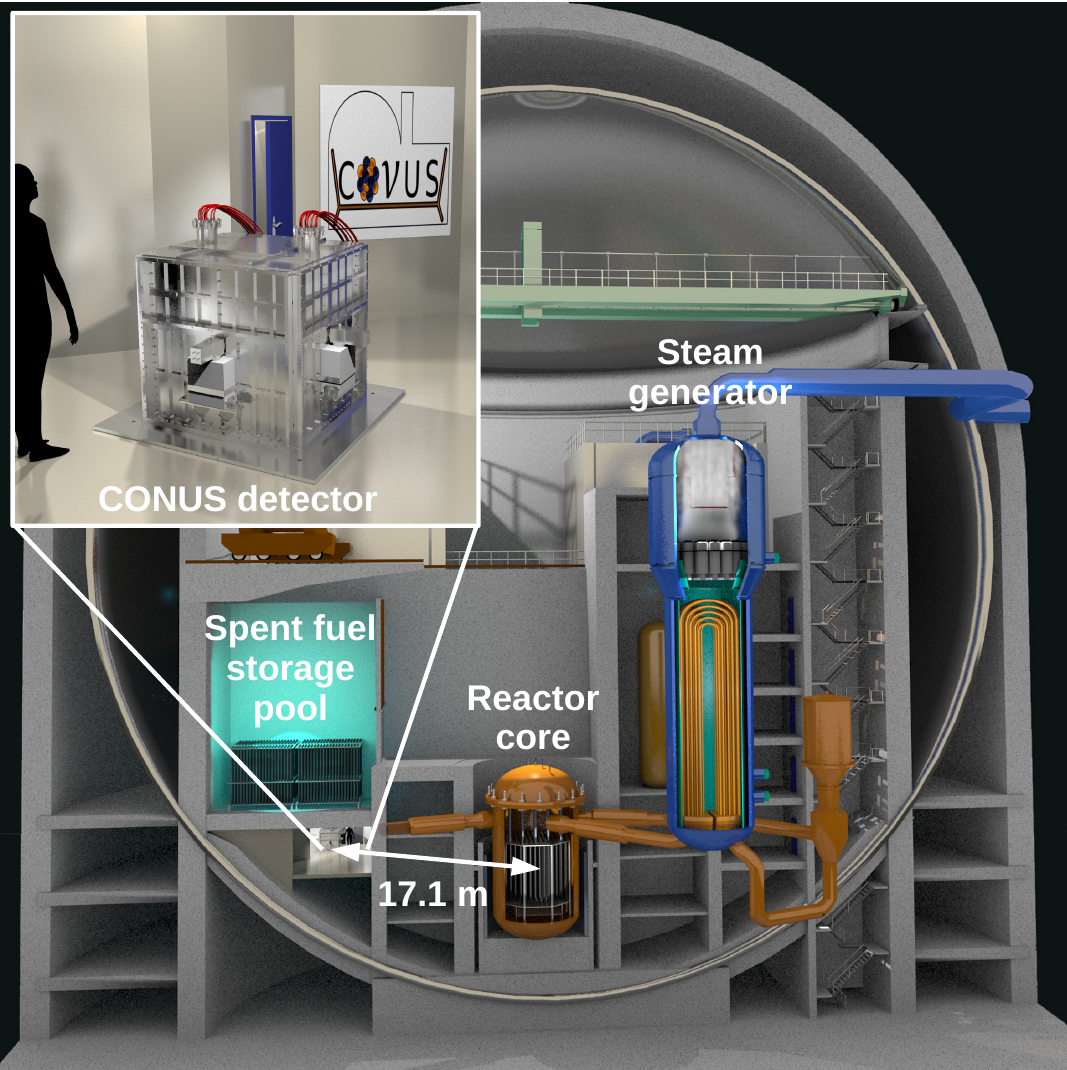
Figure 1 . Position of the Conus detector set-up within the building of the nuclear power plant at Brokdorf, Germany. It is located under the spent fuel storage pool at 17.1 m distance to the 3.9 GW (thermal power) reactor core. The vertical position of the set-up coincides approximately with the reactor core’s center. The enlarged image shows the set-up at its experimental site. Within the shown stainless steel cage, layers of lead as well as pure and borated polyethylen serve as passive shield around the embedded four HPGe detectors against external radiation and other background sources. Further, it includes plastic scintillator plates equipped with photomultiplier tubes which are used as muon